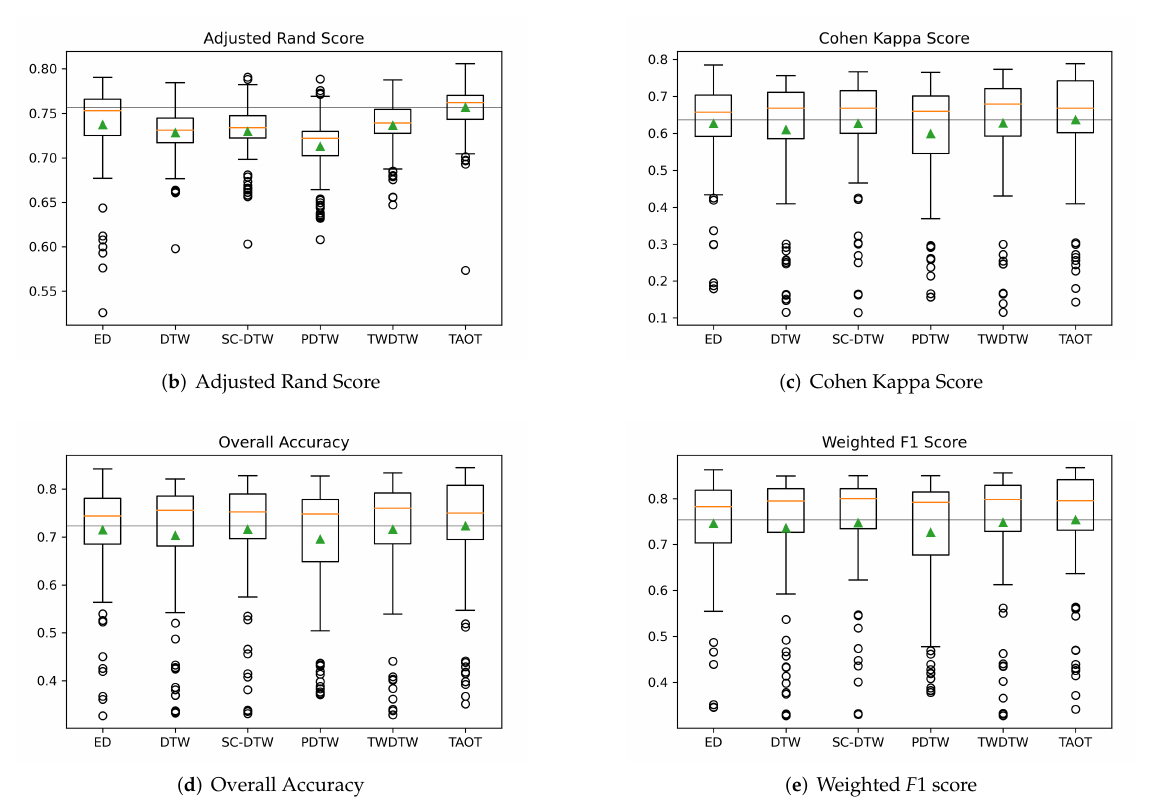
Figure 10. Distribution of each performance metric over the 100 repetitions performed on the Poyang Lake dataset. The orange line indicates the median and the green triangle indicates the mean. The gray line locates the mean value of TAOT for reference. ( a ) Adjusted Rand Score; ( b ) Cohen Kappa Score; ( c ) Overall Accuracy; ( d ) Weighted F 1 score.